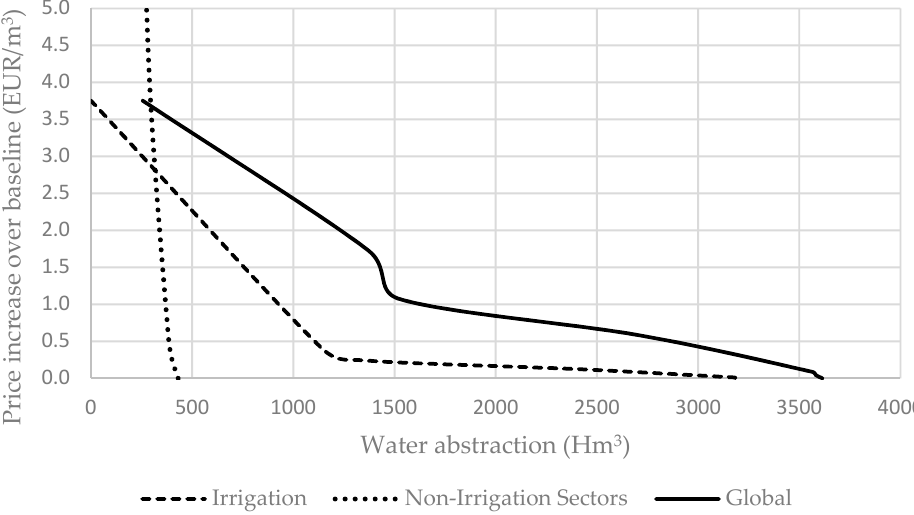
Figure 3. Elicited demand curves of water abstraction vs. water price increase (all sectors). 289